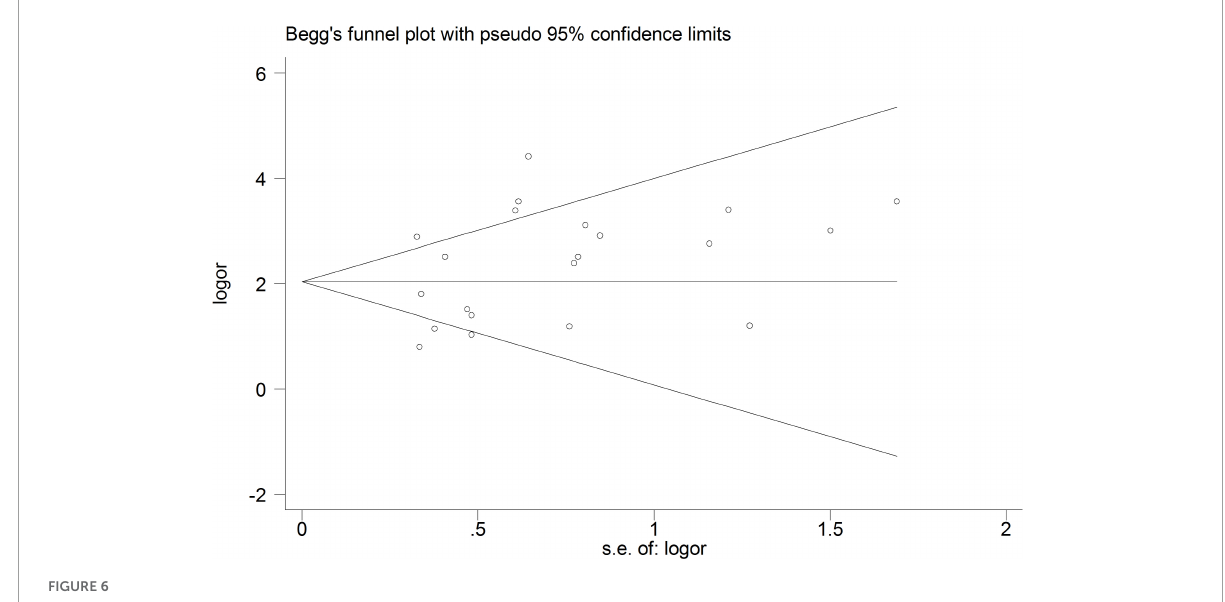
FIGURE6 Begg’s funnel plot for testing publication